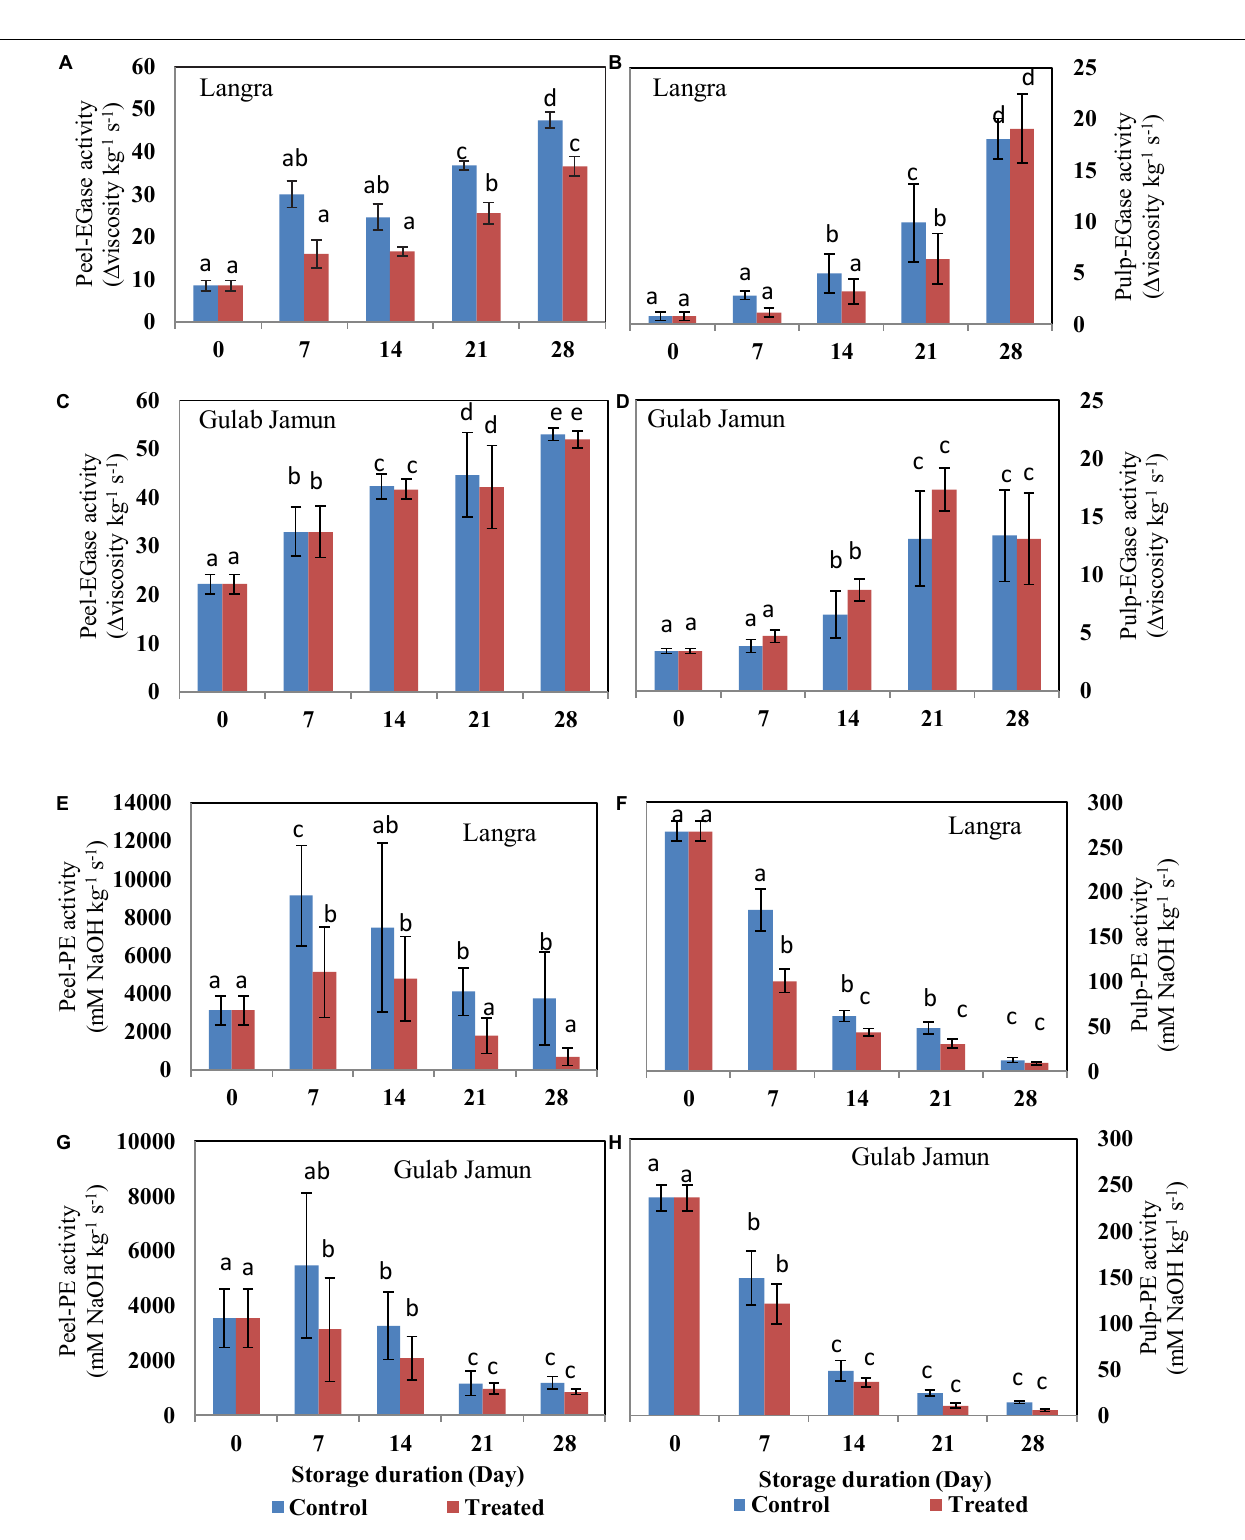
FIGURE 3 | Endo -1,4- β - D -glucanase (EGase) activity in (A) ‘Langra’ peel, (B) ‘Langra’ pulp, (C) ‘Gulab Jamun’ peel, and (D) ‘Gulab Jamun’ pulp and pectin esterase (PE) activity in (E) ‘Langra’ peel, (F) ‘Langra’ pulp, (G) ‘Gulab Jamun’ peel, and (H) ‘Gulab Jamun’ pulp treated with 0 µ M (control) or 100 µ M (treated) MT for 2 h, followed by 28 days of storage at 5 ± 1 ◦ C and 3 days of shelf life at room temperature (25 ◦ C, 90–95% RH). Measurements were taken on every 7 days of storage. Each value is the mean of three replicates ± standard error. Error bars with different small letters on the same storage period show a significant difference ( P ≤